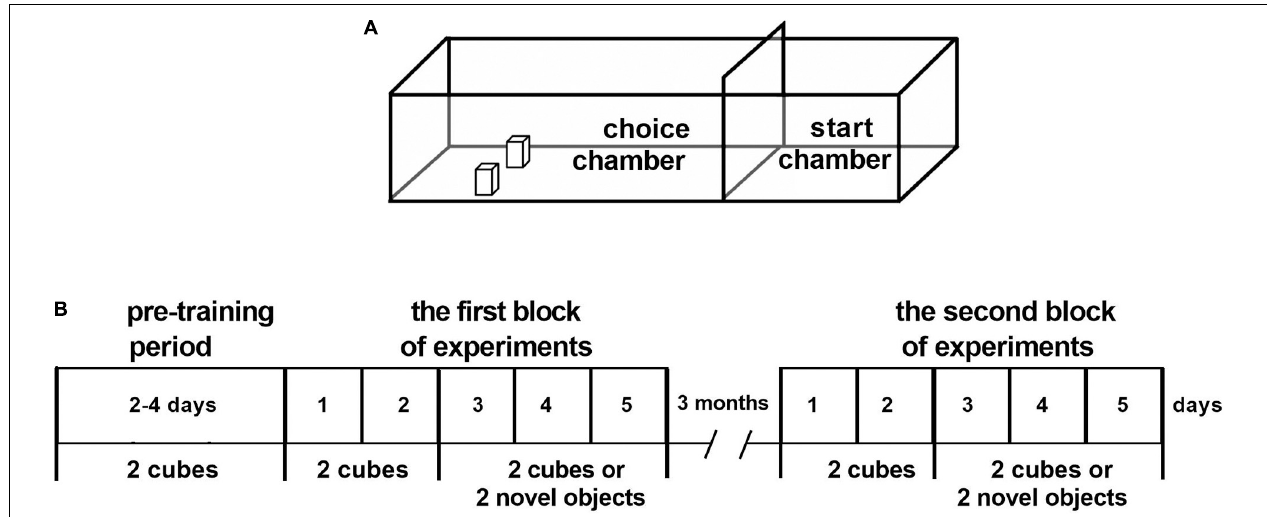
FIGURE 1 | The construction of the apparatus (A) and the schedule of the experiments (B) . (A) Apparatus with the start and choice chambers. (B) Stages of experiments: the pre-training period (2–4 days); the first block of experiments: training with the rewarded objects (cubes, 2 days) and training with the rewarded cubes or non-rewarded novel objects (3 days); a 3-month interval; and the second block of experiments (5 days) using the same paradigm as during training.